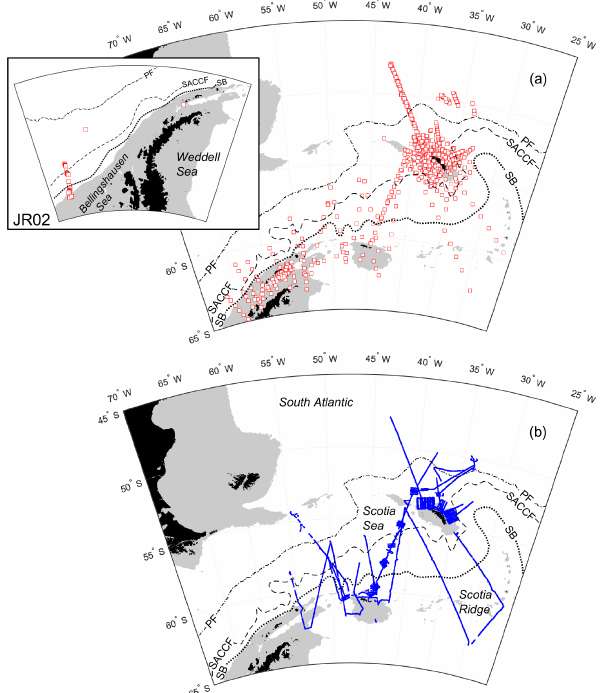
Earth Syst. Sci. Data, 15, 211–224,